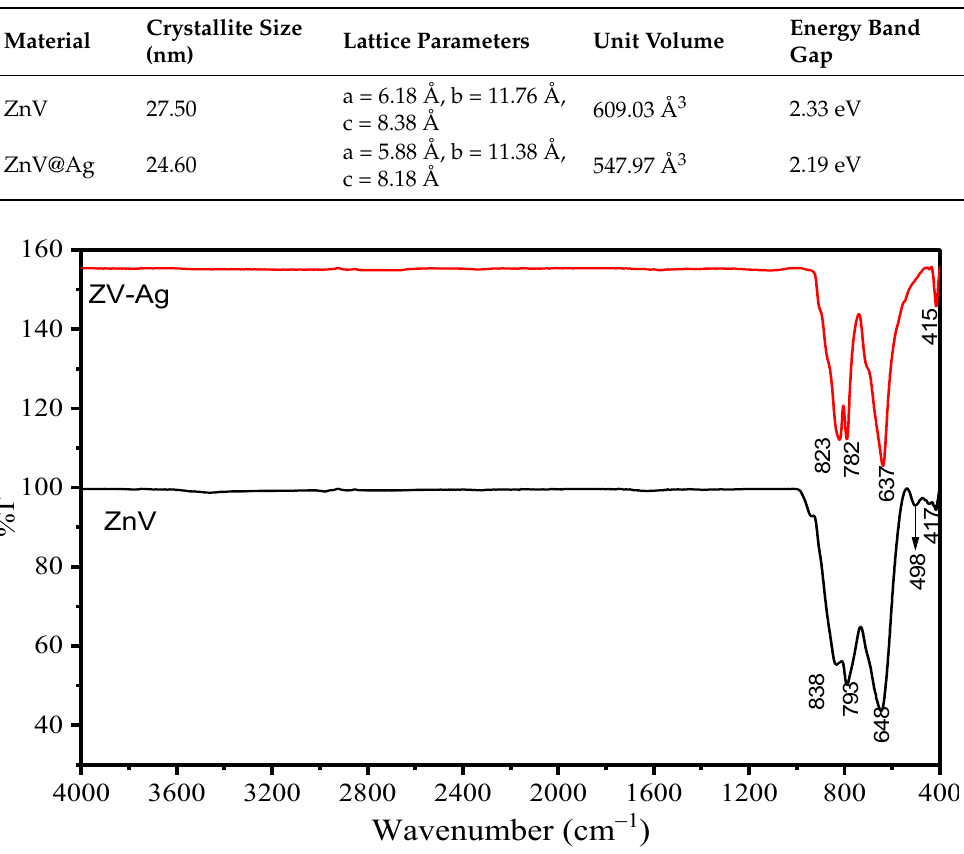
Table 1. XRD parameters such as crystallite size, lattice parameters, unit volume, and band-gap energy for ZnV and ZnV@Ag NC.